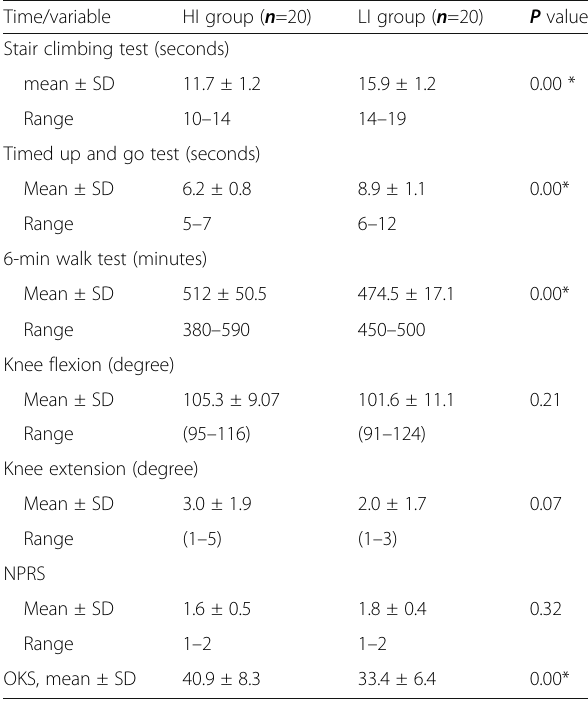
Table 4 Post-operative outcome measures of both groups